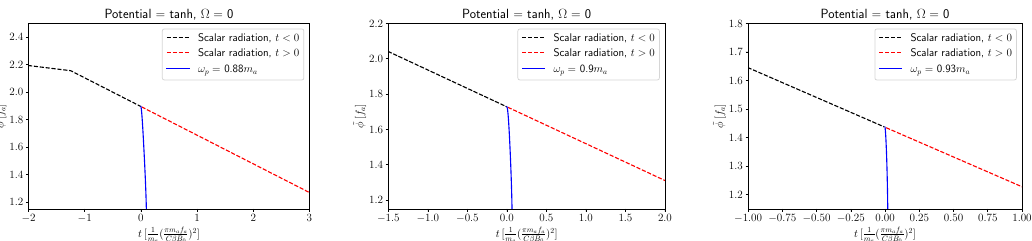
Figure 9 . Decay of the central amplitude as it would evolve through solely scalar radiation (dashed lines) and EM radiation (solid lines), for three different values of the plasma frequency when the initial frequency satisfies ω ( t = t 0 ) < ω p . We define the time t = 0 as the time at which ω ( t = (cid:16) (cid:17) 2 πm a f a 0) = ω p and we have chosen the constant = 3 · 10 4 . The data for the scalar radiation is CβB 0 loosely read from figure 4 in [23].